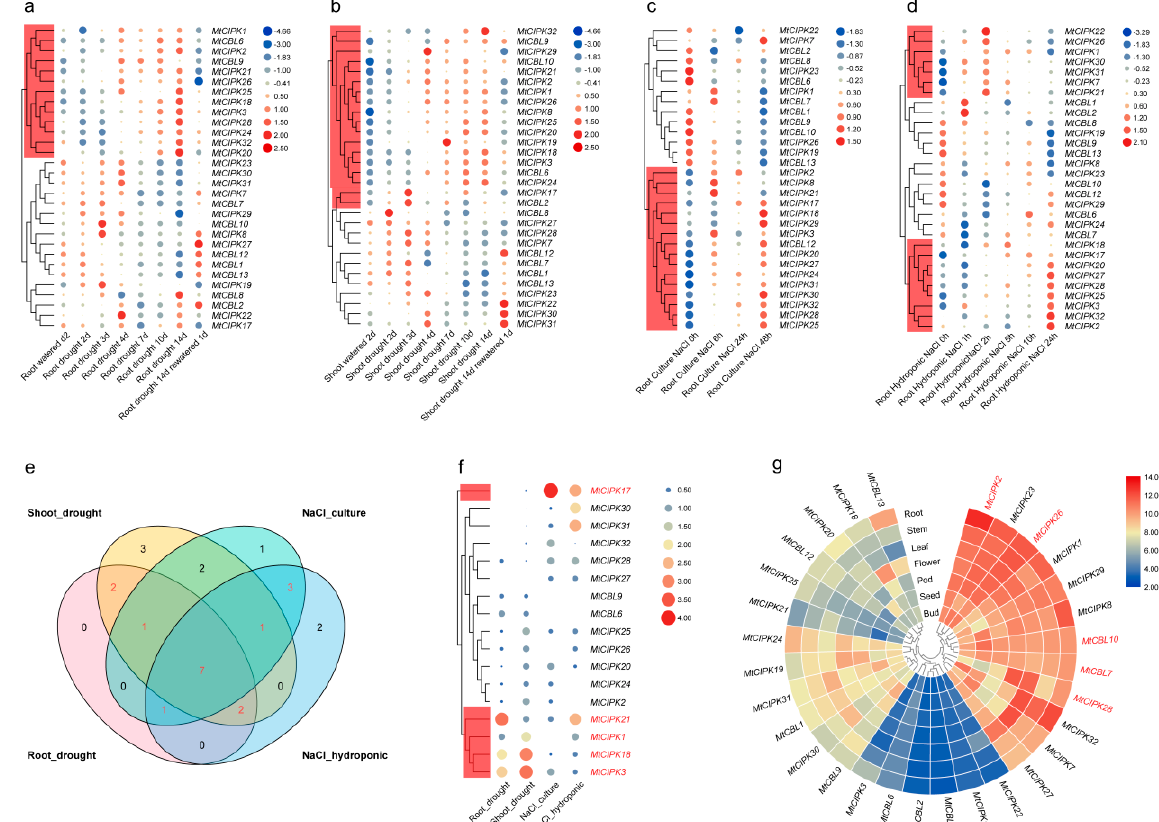
Figure 5. MtCBL and MtCIPK gene expression profiles under different treatments, different times, and different tissues retrieved from microarray data. Each column represents one treatment, each row represents one gene, and each member is normalized in the same column. The relative expression levels are log2-transformed and visualized for heatmap. The color of circles from blue to red shows the expression level from negative to positive values after normalization. The red box indicates genes with increased expression. ( a ) Gene expression of root under different drought treatment time. ( b ) Gene expression of shoot under different drought treatment time. ( c ) Gene expression of root under different NaCl-culture time. ( d ) Gene expression of root under different NaCl-hydroponics time. ( e ) Venn diagram of gene expression levels after four different treatments. ( f ) Gene expression levels of common differentially expressed genes after different treatments in the figure 5e. ( g ) Expression profiles of genes in 7 different tissues retrieved from microarray data.